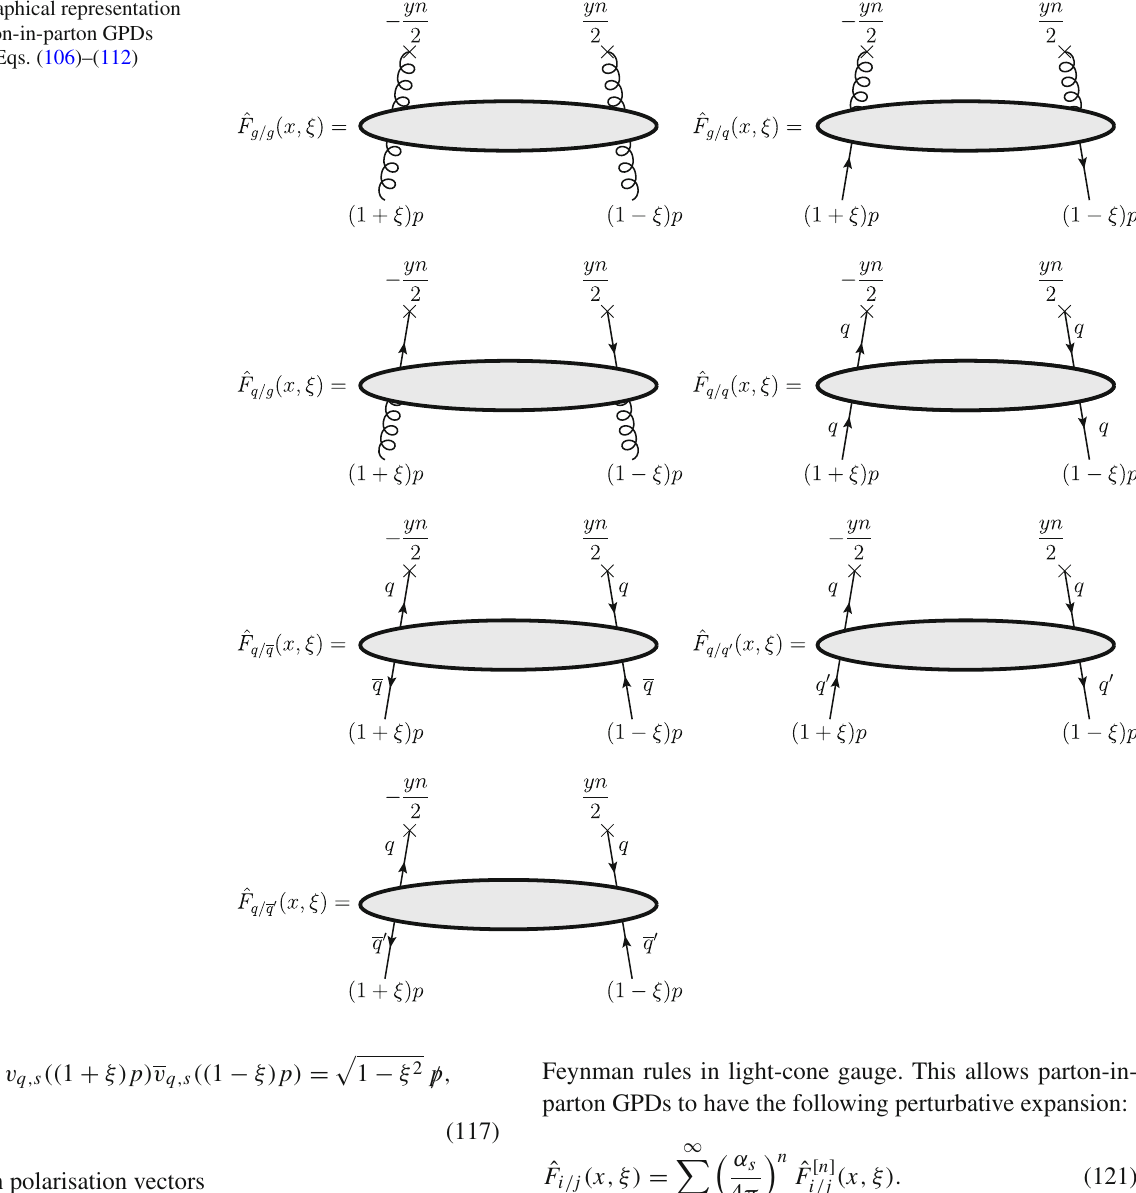
Fig. 8 Graphical representation of the parton-in-parton GPDs defined in Eqs.